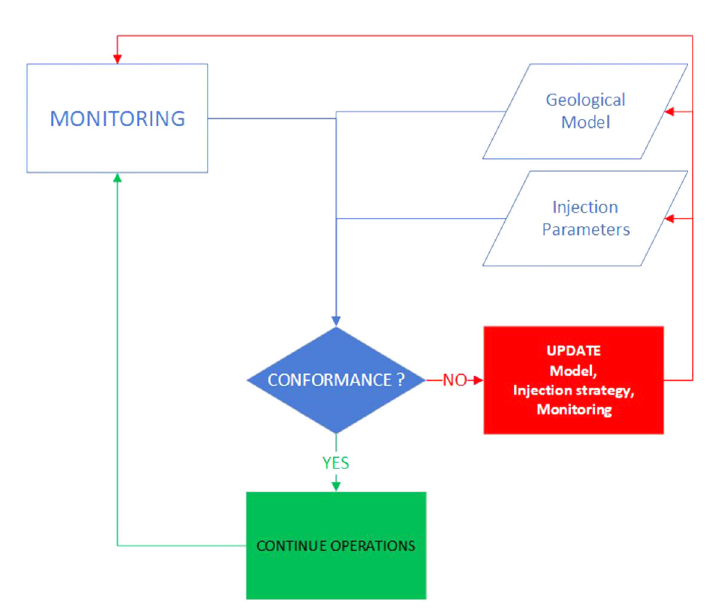
Fig. 17. – Block diagram of the MMV workflow. The geological model and the selected injection parameters are compared to the monitoring data. If there is conformance, operations can continue as planned. If not, an update of the geological model, injection strategy and monitoring should be